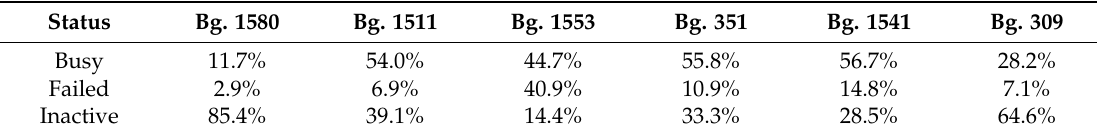
Table 8. Actual utilization of the system.